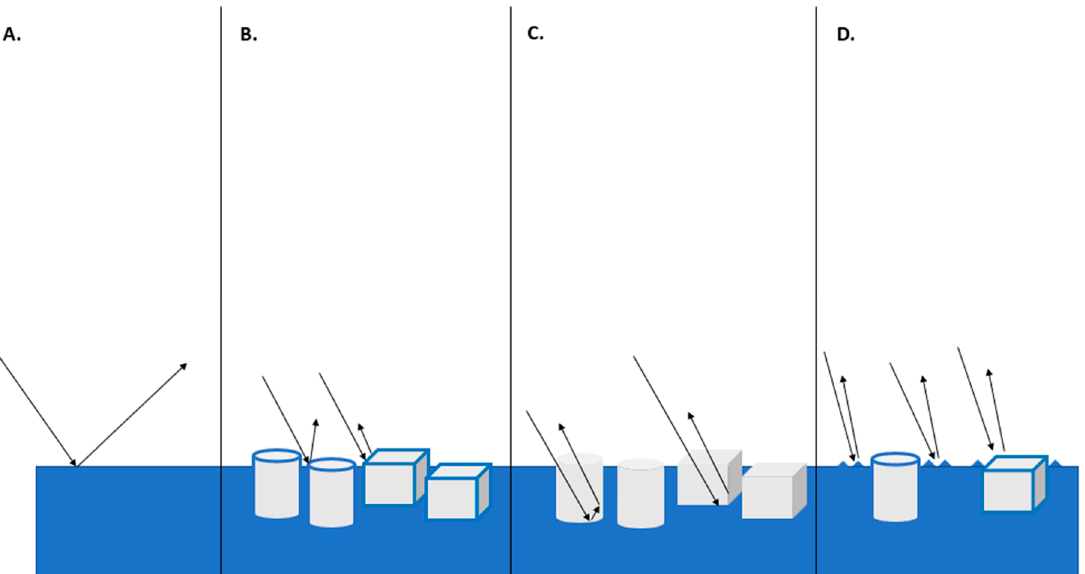
Figure 3. Radar backscatter interacting in different scenes. Black arrows: Radar signal and backscat- tering. ( A ) Specular reflection of signal from calm water with no material inside water. ( B ) ‘Direct’ scattering is a change in backscatter from ‘wet’ plastics that are partially submerged with a thin layer of water on top. ( C ) ‘Indentation’ scattering is a change in backscatter from ‘dry’ plastics that are partially submerged with no layer of water on top but are producing indentations in the water. ( D ) ‘Wave-Generation’ scattering is a change in backscatter from the addition of capillary waves generated from the presence of plastic items interacting with